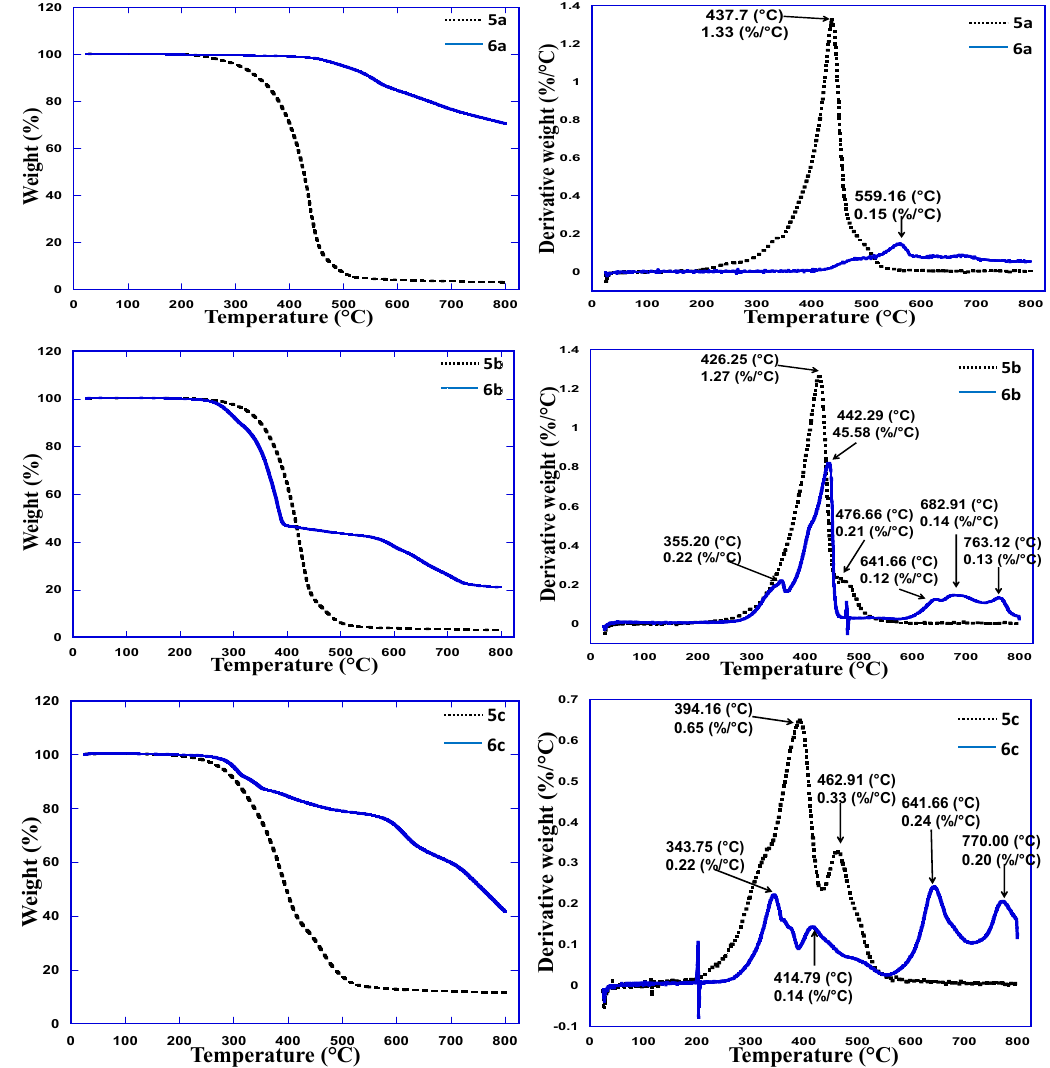
Table 1. Weight loss percentage for the polymers Compounds 5a to 5c and 6a to 6c .